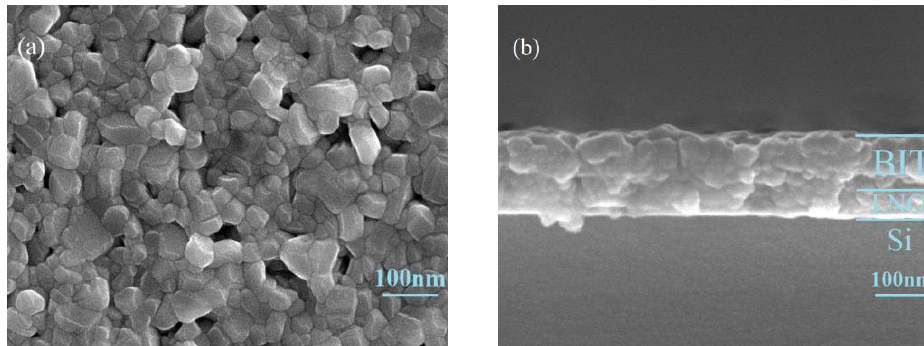
Figure 2. SEM micrographs of the BIT films prepared on LNO/p-Si substrate annealed at 700 °C for 20 min. ( a ) Topography image, and ( b ) cross-sectional view.